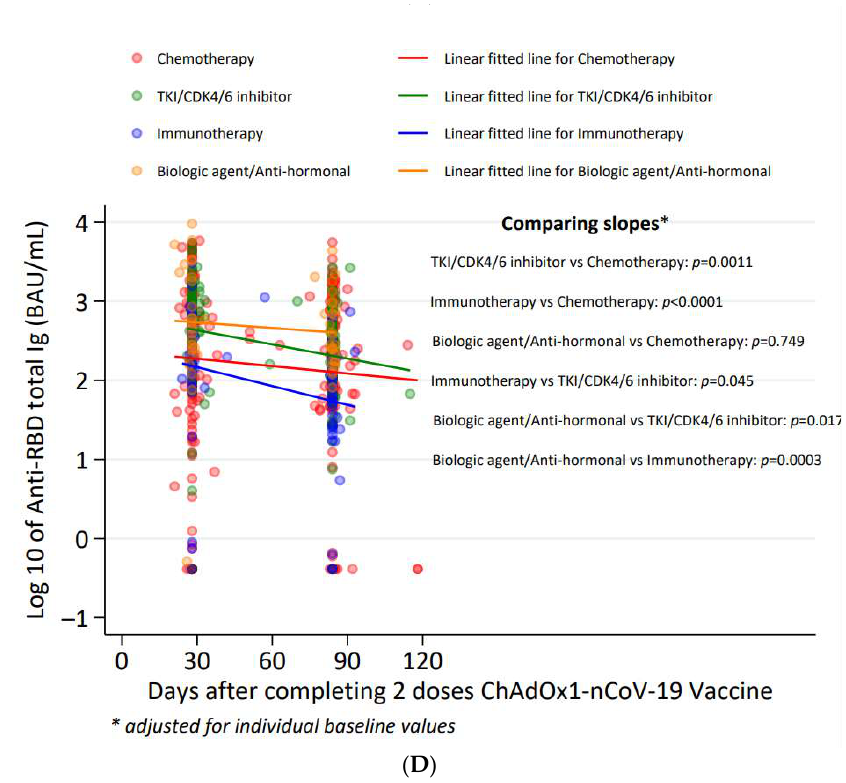
Figure 2. Decay rates of SARS-CoV-2 binding antibody levels at 1 and 3 months after two doses of the ChAdOx-nCoV-19 vaccine in cancer (n = 290) and healthy cohorts (n = 84). ( A ) Comparison of anti-RBD total Ig at 3 months after completing 2 doses of ChAdOx1-nCoV-19 between the cancer and healthy groups—adjusted for individual baseline values (at 1 month). ( B ) Slopes of regression lines ad- justed for individual baseline values (at 1 month): slope (cancer) = − 0.004155 (log 10 scale)/day, slope (healthy) = − 0.004736 (log 10 scale)/day. ( C ) Comparison of anti-RBD total Ig at 3 months after com- pleting 2 doses of ChAdOx1-nCoV-19 between treatment types among cancer patients—adjusted for individual baseline values (at 1 month). Grey line represents patients with decreasing antibody levels and colored lines represent patients with stable or rising levels. ( D ) Slopes of regression lines adjusted for individual baseline values (at 1 month): slope (chemotherapy) = − 0.002552 (log 10 scale)/day, slope (TKI/CDK4/6 inhibitor) = − 0.005772 (log 10 scale)/day, slope (immunotherapy) = − 0.008619 (log 10 scale)/day, slope (biologic agent/anti-hormonal) = − 0.002066 (log 10 scale)/day. * In order to consider multiple comparisons adjustment using Bonferroni, the calculated p -values should be compared with <0.05/6 = <0.0083 in considering